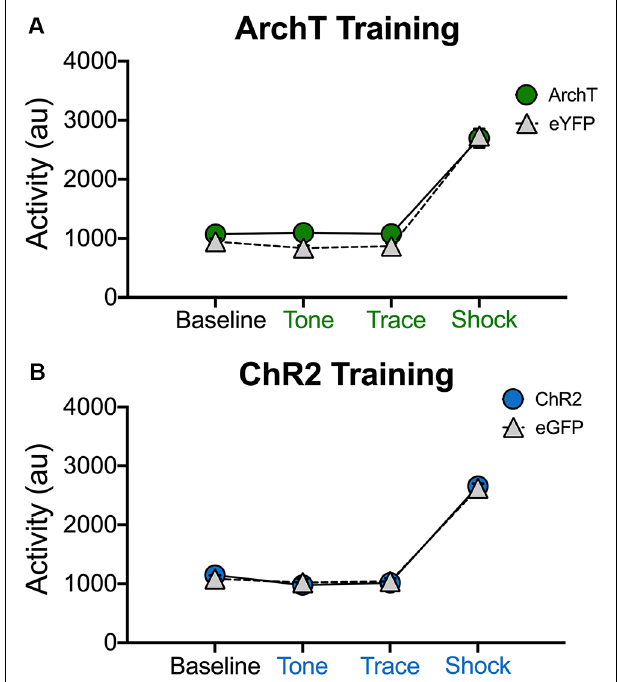
FIGURE 5 | Stimulation and inhibition of dCA1 do not alter locomotor activity or shock responsivity. (A) Average motion (arbitrary units) during the last 20 s of baseline and the first tone, trace, and shock periods in Experiment 3 (inhibition during trace fear encoding; Mean ± SEM). (B) Average motion during the last 20 s of baseline and the first tone, trace, and shock periods in Experiment 4 (stimulation during trace fear encoding; Mean ±